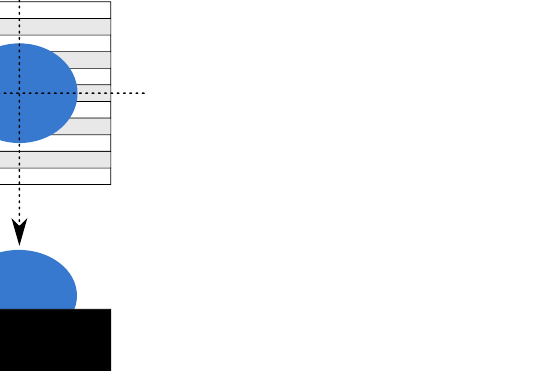
Figure 12. Comparison of CAs on differently structured MAE surfaces from material S with 1 4 laser passages. ( a ) Comparison at B = 0.0 T. ( b ) Comparison at B = 0.4 T. ( c ) Relative change of × CA ∆ θ / θ 0 versus magnetic field. ( d ) Directional anisotropy of CA on lamellas with respect to the viewing